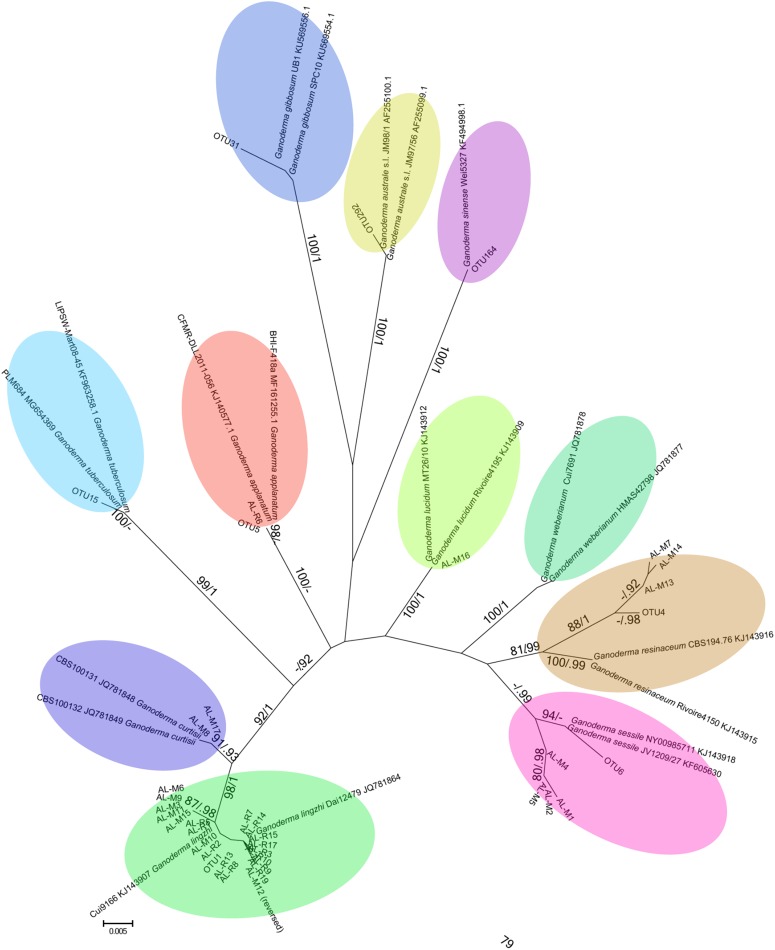
Unrooted maximum likelihood phylogenetic tree reconstructed using ITS sequences generated in this molecular survey together with reliable reference sequences for identification at the species level. Bootstrap values are indicated on branches, followed by the posterior probability of the Bayesian phylogeny that had identical topology. Reference sequences are annotated with species names and GenBank Accession numbers. Clusters of sequences shaded were found in this study, and sequence branches with the same color are the same species. Reference sequences for G. weberianum were included to show the relationship to the G. resinaceum sensu lato species identifications. Sequences generated with Sanger sequencing are labeled as AL-M# (GYO reishi kits) and AL-R# (manufactured products), and sequences generated with Illumina MiSeq are labeled as OTU# (manufactured products).